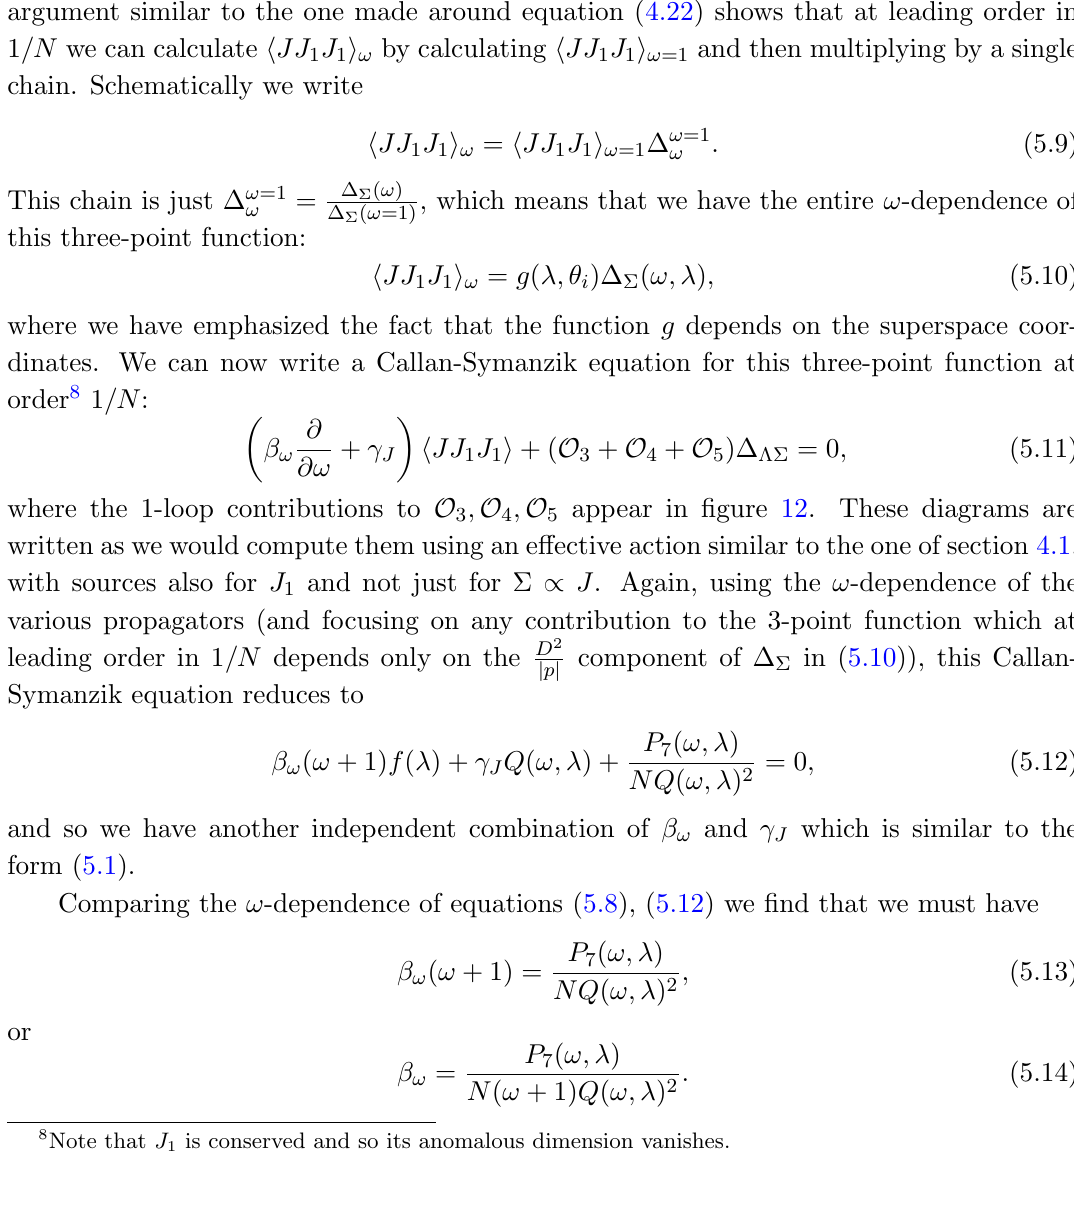
Figure 12. Diagrammatic expressions for connected to the J with a ∆ ΛΣ